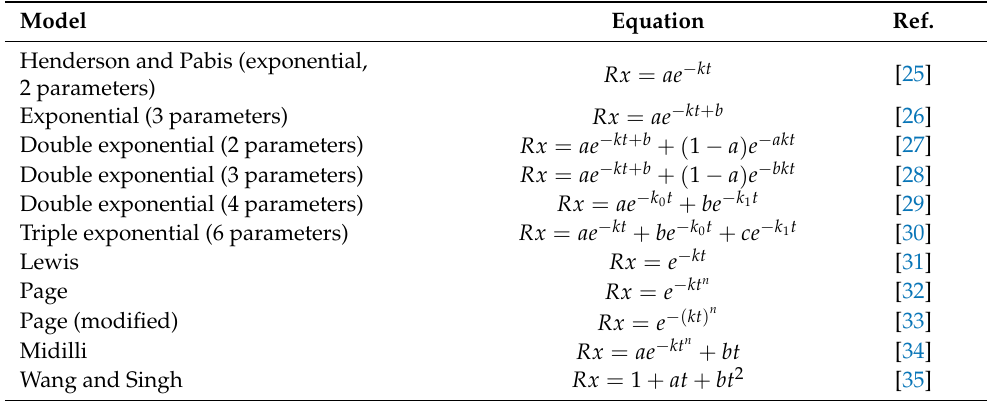
Table 1. Drying models